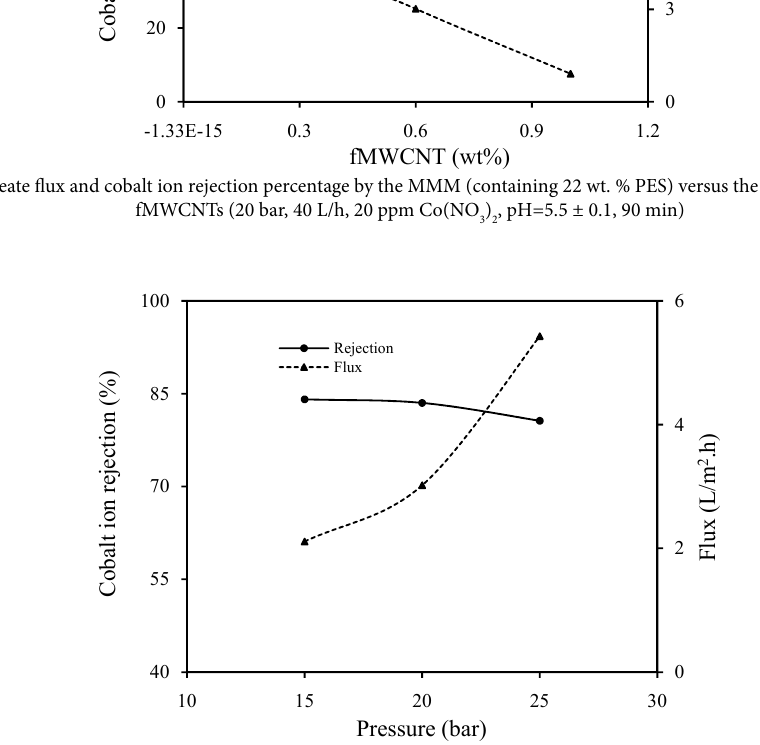
Fig. 7. Permeate flux and cobalt ions rejection percentage by the MMM containing 22 wt. % PES and 0.6 wt. % fMWCNTs versus operating pressure (40 L/h, 20 ppm Co(NO 3 ) 2 , pH=5.5±0.1, 90 min)